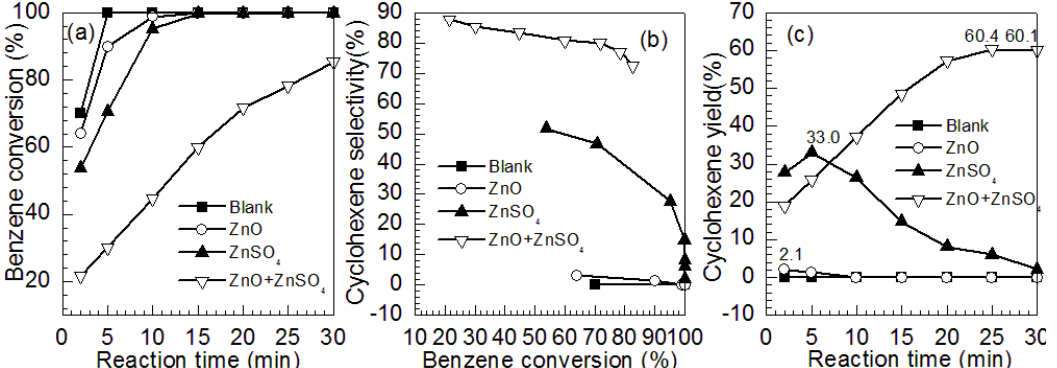
Figure 7. Catalytic activity towards cyclohexene formation from selective hydrogenation of benzene over Ru-4.7 catalyst with different additives ( m cat = 2.0 g, v H2O = 280 mL, v benzene = 140 mL, T = 423 K, p H2 = 5.0 MPa). ( a ) Catalytic activity towards benzene conversion, ( b ) catalytic selectivity towards cyclohexene formation and ( c ) yield of cyclohexene over Ru-4.7 catalyst with different additives.